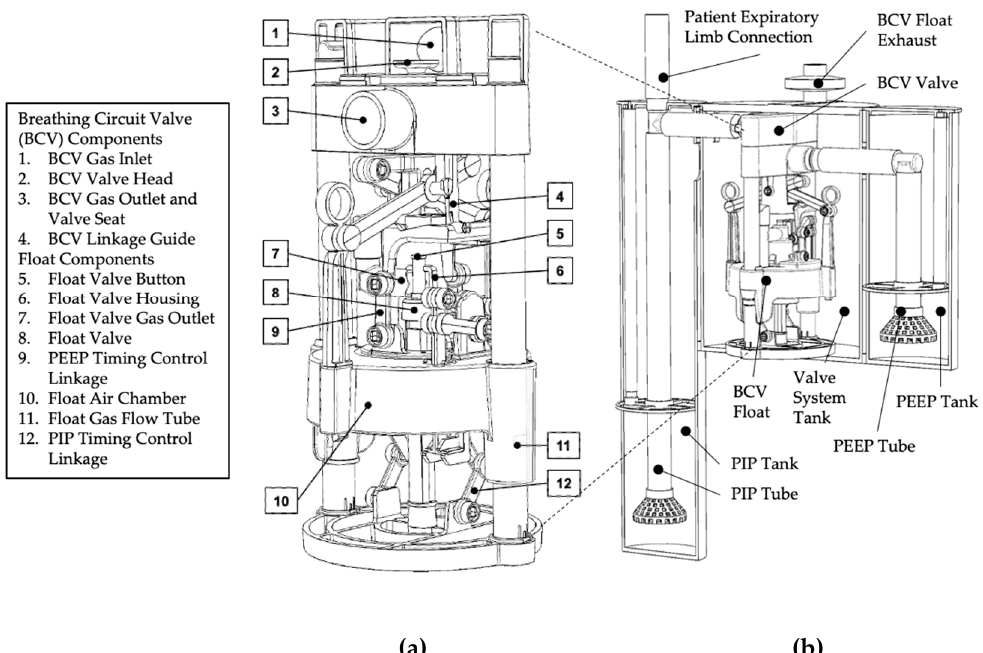
Figure 2. A diagram of the valve system and complete BubbleVent device. ( a ) Breathing Circuit Valve Detail : the key sub ‐ assemblies and parts of the valve system; the float components are submerged below the waterline. ( b ) BubbleVent Detail : The key assemblies within the BubbleVent device; PIP and PEEP tube ends are submerged below a controlled water level in the PIP and PEEP tanks. Table 1. The relationship between the pressure delivered and the states of key bubble vent Sub- Assemblies and